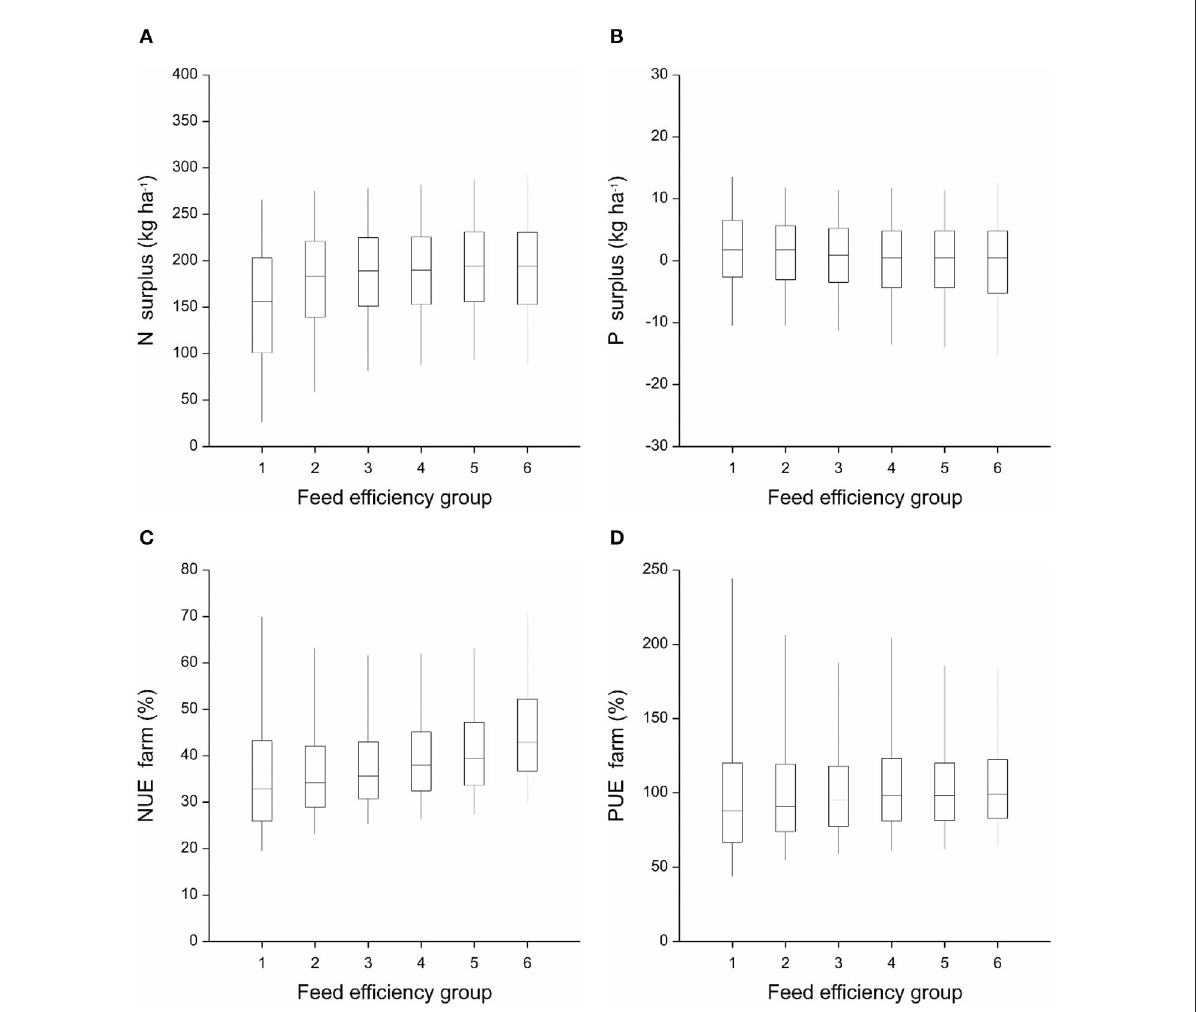
FIGURE2 Boxplots of indicator values per group of farms. (A) Nitrogen surplus per ha of farmland; (B) Phosphorus surplus per ha of farmland; (C) Nitrogen use efficiency (NUE) at farm level; and (D) Phosphorus use efficiency (NUE) at farm level. The 12.770 farms were ordered in descending order